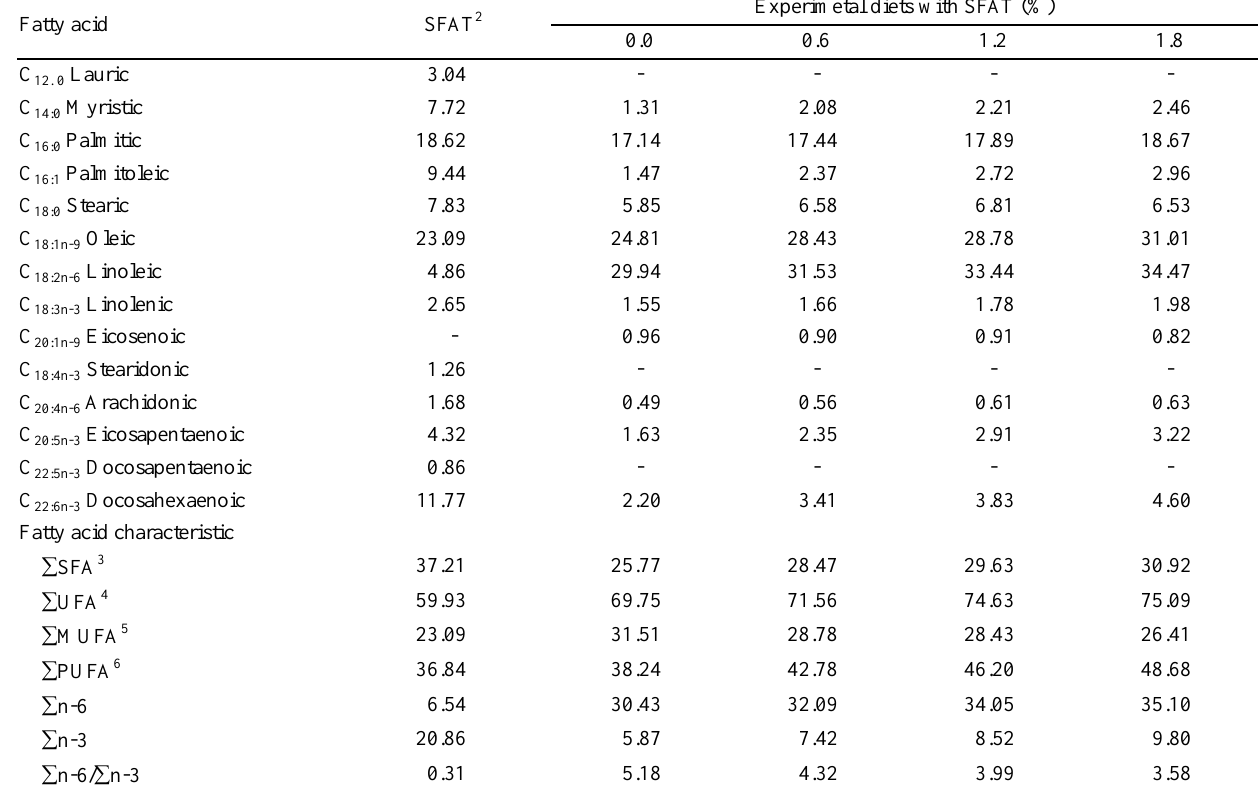
Fatty acid SFAT